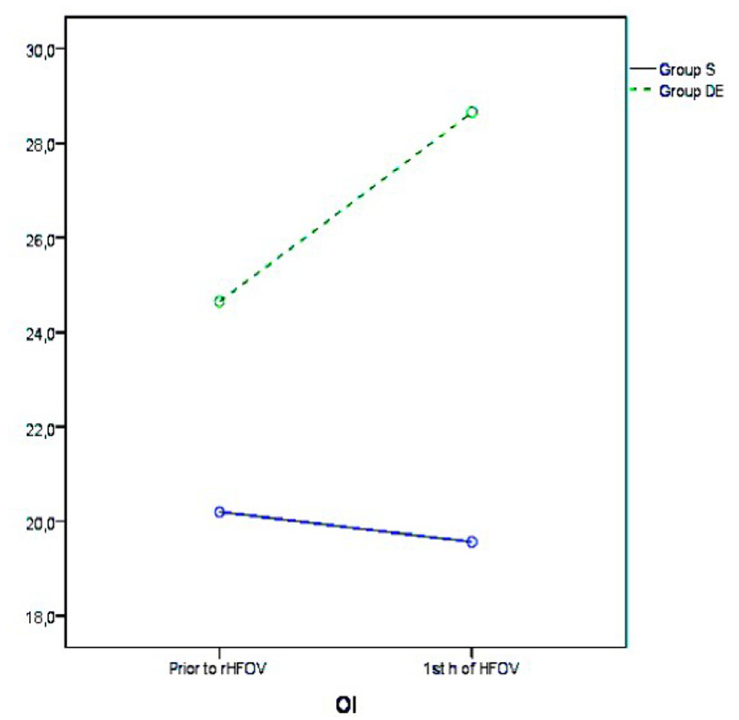
Fig 4. Evolution of